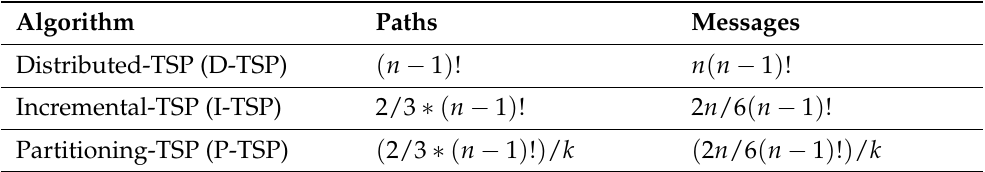
Table 2. Summary of complexity